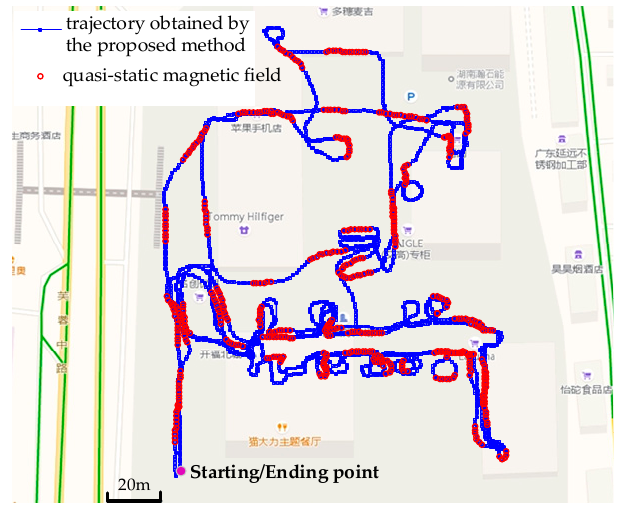
Figure 14. The detection results of quasi-static magnetic field of the proposed method.